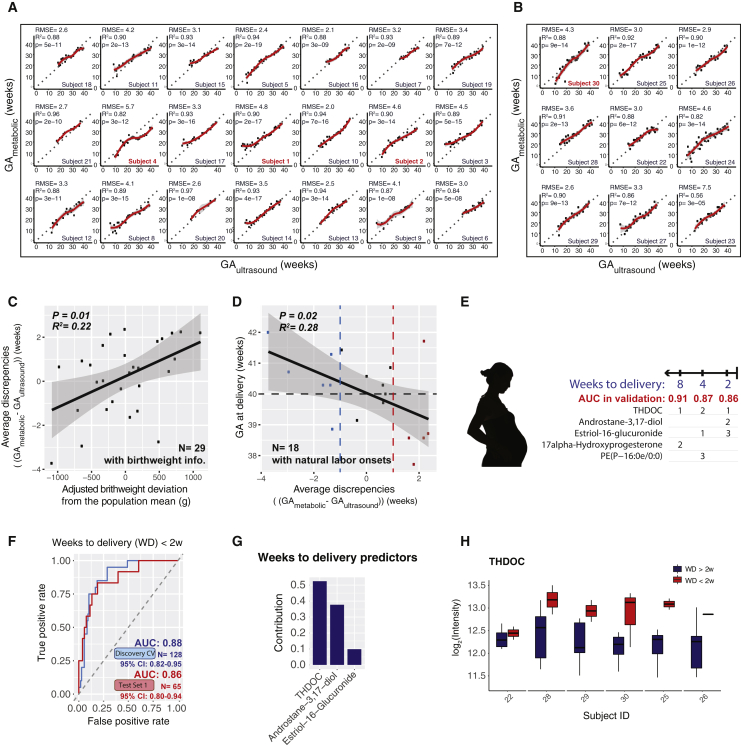
Personal Metabolic Clock of Pregnancy Linked with Timing of Delivery and Fetal Growth(A and B) Highly correlated patterns of the metabolic-clock-predicted gestational age (GAmetabolic) of the five-metabolite model with the gestational age estimated by the first-trimester ultrasound (GAultrasound) at the individual level in the cross validation (A) and test set 1 (B). Note that the outlier sample with negative prediction value in Figure 4C belonged to the last subject of the test set 1 and did not show in the current plot with the y axis scale limitation.(C) The average discrepancies between metabolic-clock-predicted gestational age and ultrasound-estimated gestational age (Δ(GAmetabolic-GAultrasound)) were significantly correlated with the fetal growth deviation from the population by person. All 29 subjects who had baby birth weight information are included here. The 95% confidence interval for the linear regression is represented by the gray area.(D) Average discrepancies between GAmetabolic and GAultrasound (Δ(GAmetabolic-GAultrasound)) were negatively correlated with the actual delivery weeks (by ultrasound-estimation). All 18 subjects who had natural labor onset are included here. Dashed lines marked the ultrasound estimated GA at 40 weeks (due date, black), GAmetabolic one week earlier than the GAultrasound (blue), and GAmetabolic one week later than the GAultrasound (red). The 95% confidence interval for the linear regression is represented by the gray area.(E) Summary of prediction models of 2, 4, and 8 weeks approaching delivery, using two to three metabolites. The contribution rank of each predictor in every model is listed as number 1, 2, and 3. The weeks to delivery were built using samples of the third trimester (> 28 weeks). AUCs in the validation cohort (test set 1) are listed.(F) The logistic regression model based on three metabolites can accurately identify the third-trimester plasma samples approaching the delivery (weeks to delivery [WD] < 2w; only women with natural labor onset included).(G) Contribution of the three metabolites to the prediction model of 2 weeks approaching delivery.(H) Metabolite THDOC showed abundance separations before or after 2 weeks approaching the delivery, except in one subject. See Figure S6 for other metabolites in the model. Note that the discovery results were from the 10-fold CV instead of direct fitting to avoid over-fitting.See also Figure S6 and Table S4.